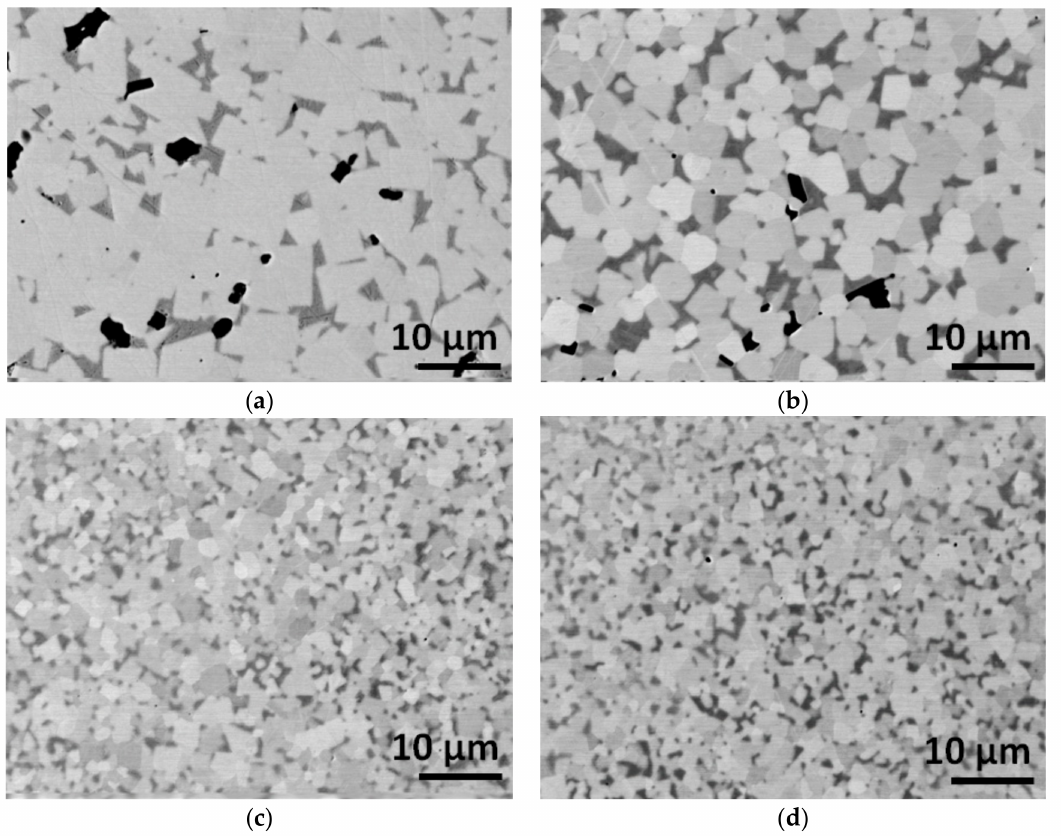
Figure 8. Influence of Mo content on the microstructure of NbC-12 vol % Ni based cermet sintered for 1 h at 1420 ◦ C. ( a ) NbC-12Ni, ( b ) (NbC-5Mo)-12Ni, ( c ) (NbC-10Mo)-12Ni, ( d ) (NbC-15Mo)-12Ni